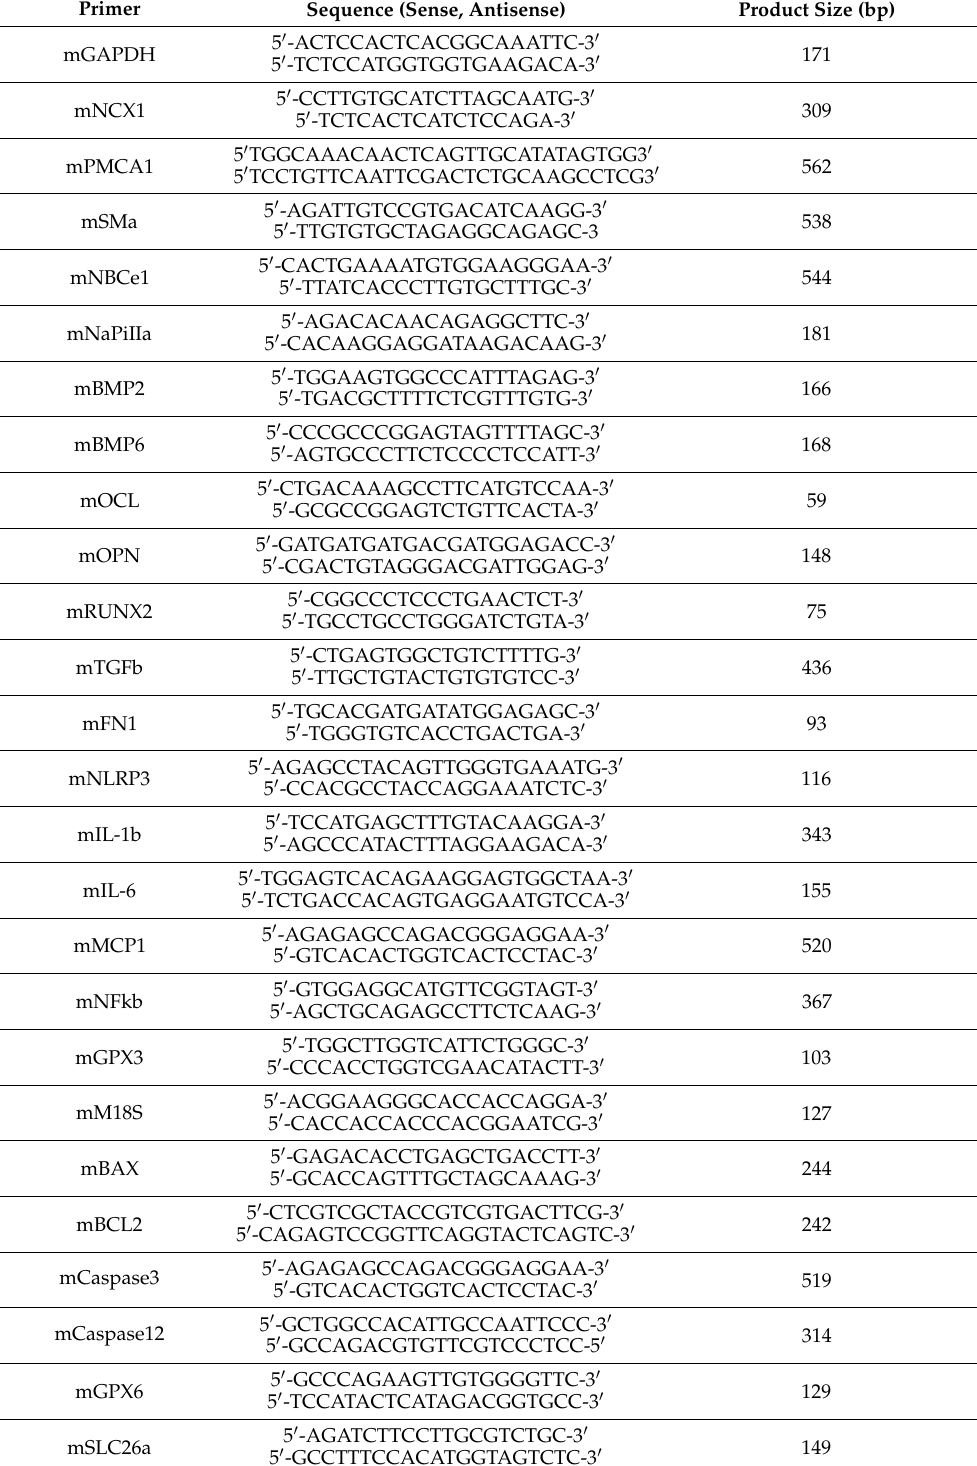
Table 1. PCR Primer